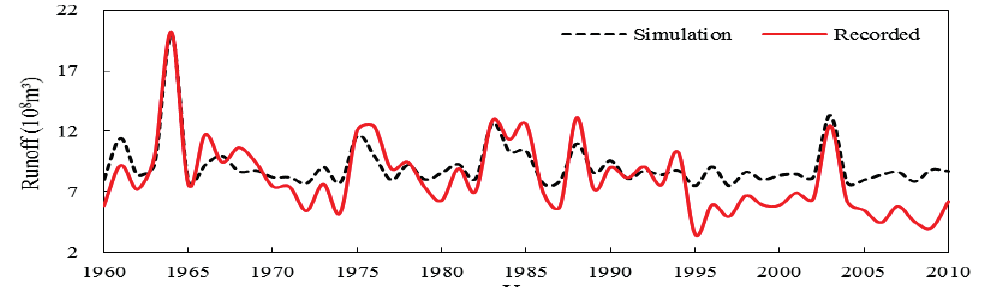
Fig. 4 Yearly series of observed and simulated runoff for 1960–2010 in